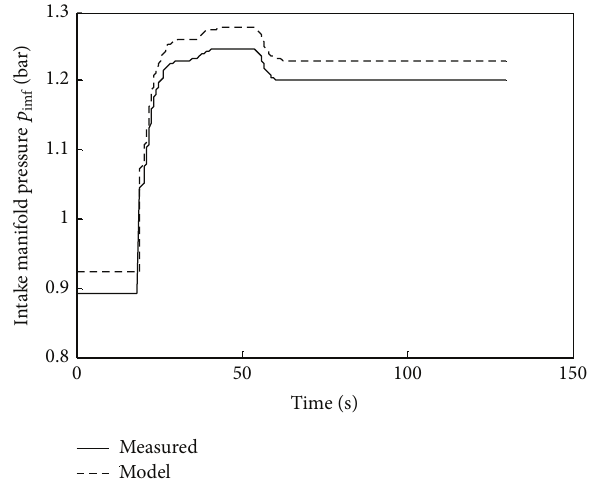
Figure 23: Measured and modeled results of intake manifold